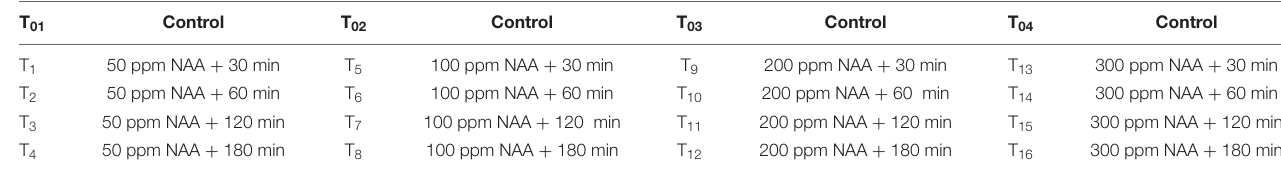
TABLE 1 | Different treatments (T 1 to T 15 ) of NAA doses (ppm) at different time durations. T